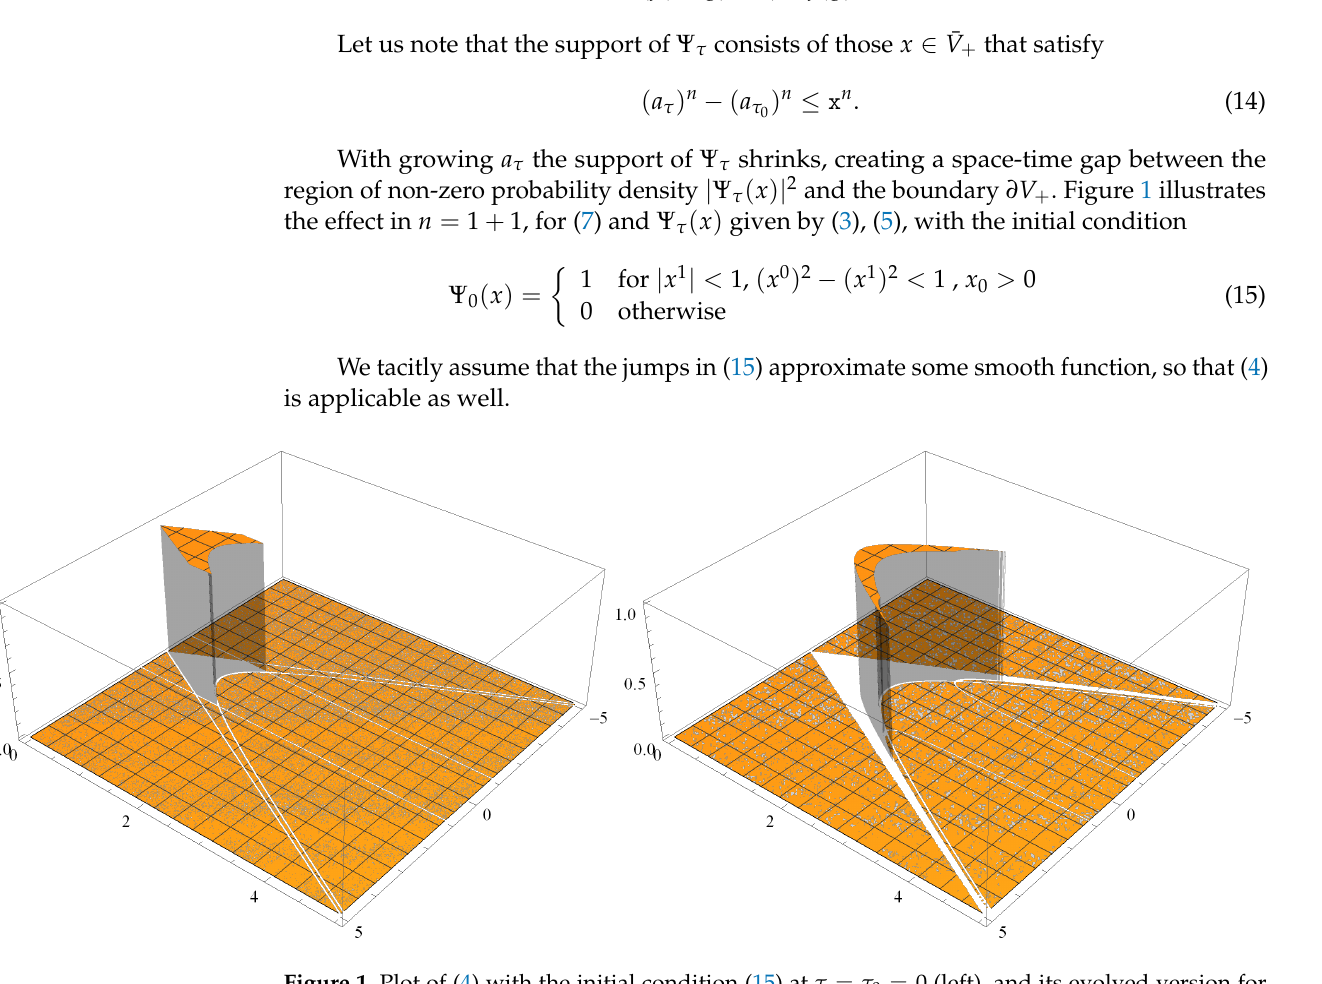
√ τ = c 2 t 2 − x 2 , in